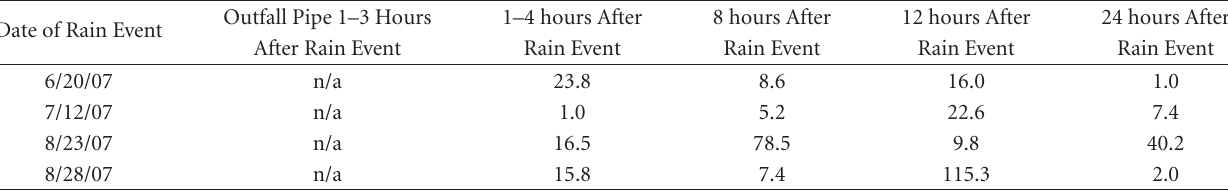
Table 6: E. coli concentrations ( ∗ MPN/100 mL) from beach water collected at time intervals following the triggering of a rain event at Nicolet this beach using ANOVA (Table 1). Likewise, using Sche ff e matrix analysis, there was no significant di ff erence between E. coli concentrations at any sampling times after a rain event and the seasonal E. coli